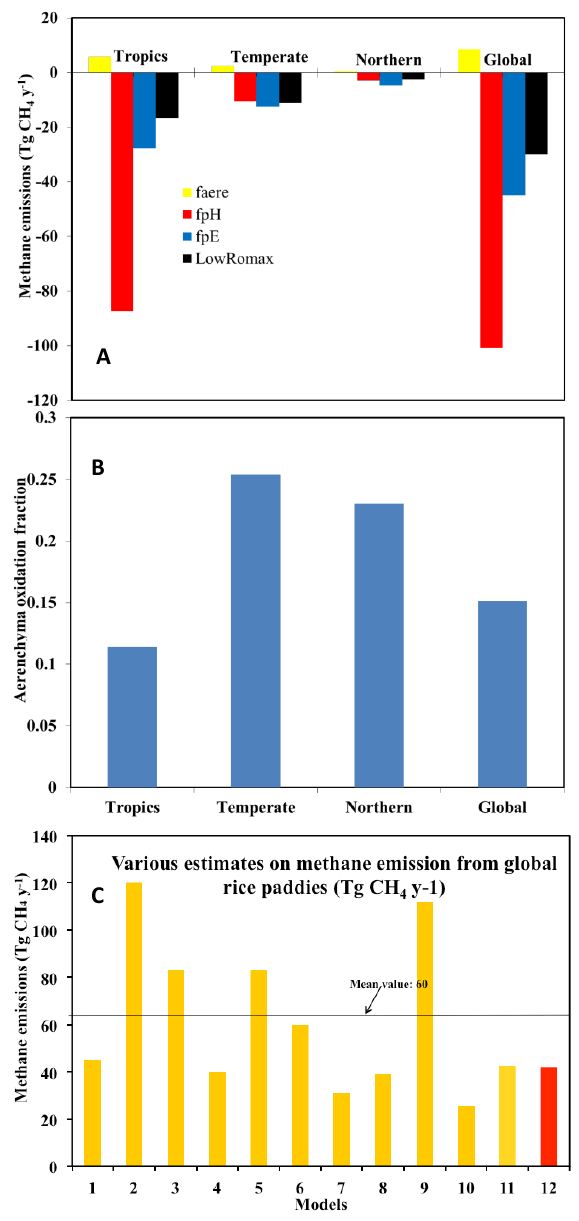
Fig. 13. A : Sensitivity analysis of each variable. The number on the y-axis indicates the change in net annual mean methane emission associated with changes in each variable. B : Prognos- tic aerenchyma oxidation fractions at different regions. C : Com- parison of global methane budget from rice paddies estimated in our model and other models. 1: Seiler et al. (1984); 2: Holzapfel- Pschorn and Seiler (1986); 3: Bouwman (1990); 4: Sass